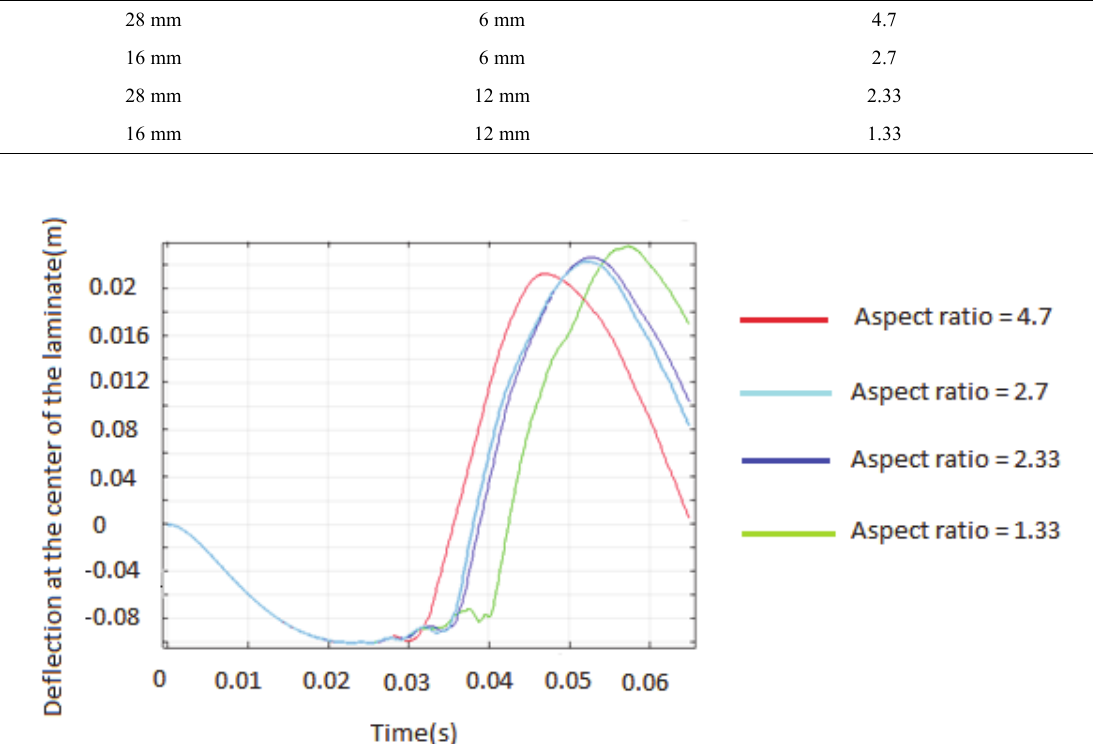
Fig. 10: Time dependence of the maximum deformation of a broken laminate in function of time, the pane being fixed by structural joints having different shape and dimensions. The impact of joint aspect ratio the rigidity of a joint has been demonstrated in a previous work and published in [14]; amongst the tested geometries, the 28*6 mm 2 joint possesses the greater rigidity (larger bite, low thickness, large aspect ratio). Joint rigidity influences the membrane deflection as the amplitude of second peak is smaller and the maximum deformation occurs earlier than for other joint